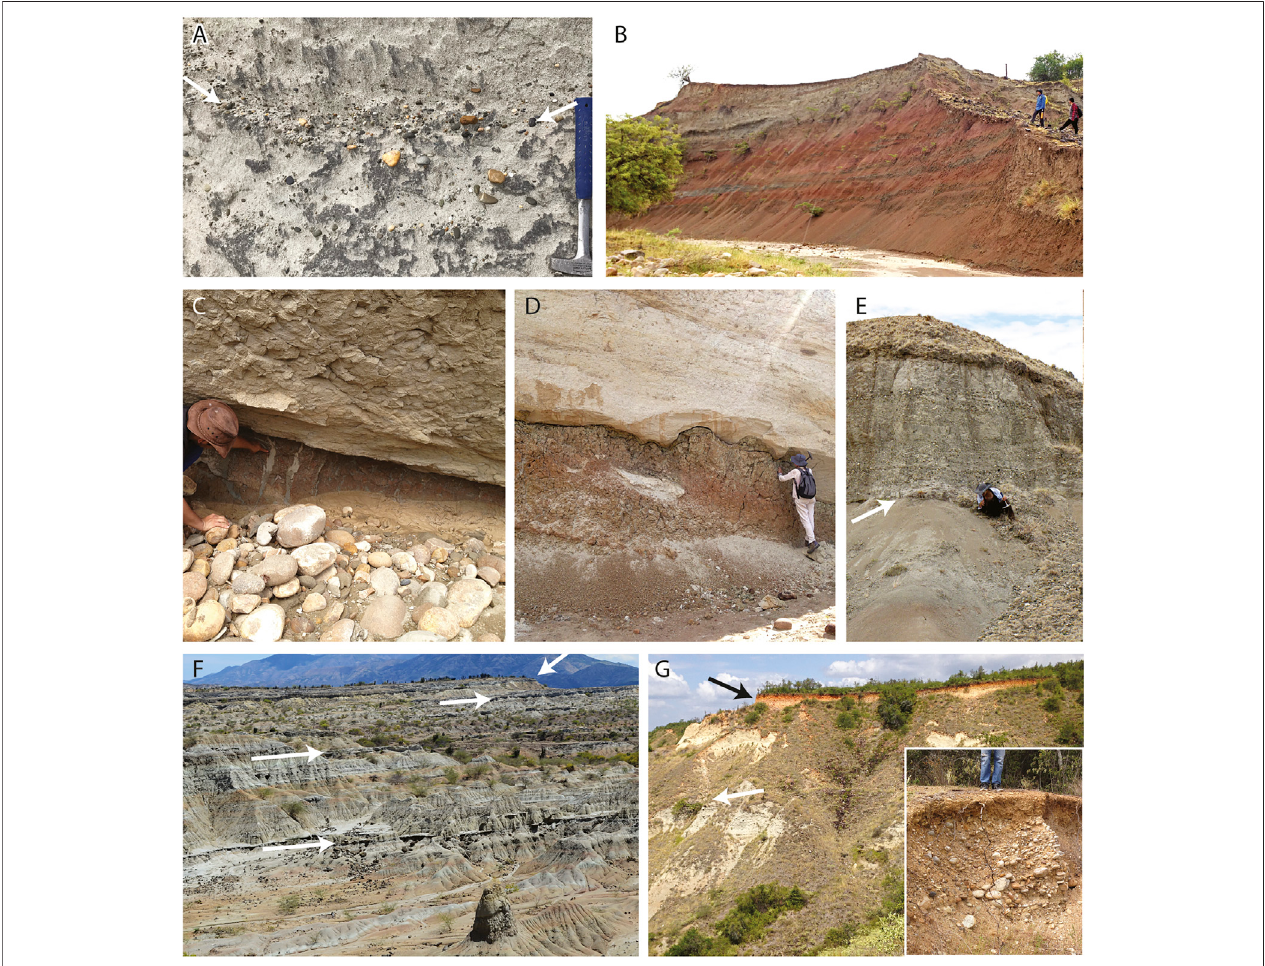
FIGURE 5 | Field photographs of strata of the Honda Group. (A) Trough cross-strati fi ed (arrows) medium-grained sandstone with imbricated pebbles of the CerbatanaConglomerateBeds(quadrangleG11in Figure4 ). (B) MudstoneatthebaseoftheSanAlfonsoBeds,nearCerroGordo(quadrangleF5in Figure4 ). (C) , (D) Mud-cracks and erosive contact respectively, in red muddy/sandy strata of the San Alfonso Beds (quadrangle H10 in Figure 4 ). (E) Sharp basal contact (arrow) of the Cerbatana Conglomerate Beds (quadrangle D8 in Figure 4 ). (F) Gently dipping strata in the Chunchullo Beds in quadrangle H9 in Figure 4 , notice the mappable sandstonebedsand bedsetswithinthesequence(arrows). (G) Dissectedalluvialdeposits(black arrow)cappingstrata oftheCerroGordoBedsmarkedbywhitearrow (quadrangle G5 in Figure 4 ). Inset shows close up of alluvial deposits showing the typical size distribution.